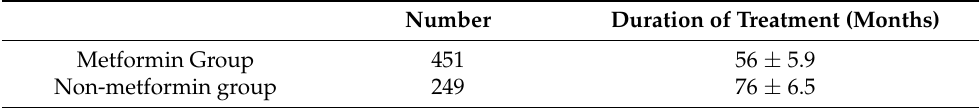
Table 1. Two groups with mean treatment duration. Number Duration of Treatment (Months) Metformin Group 451